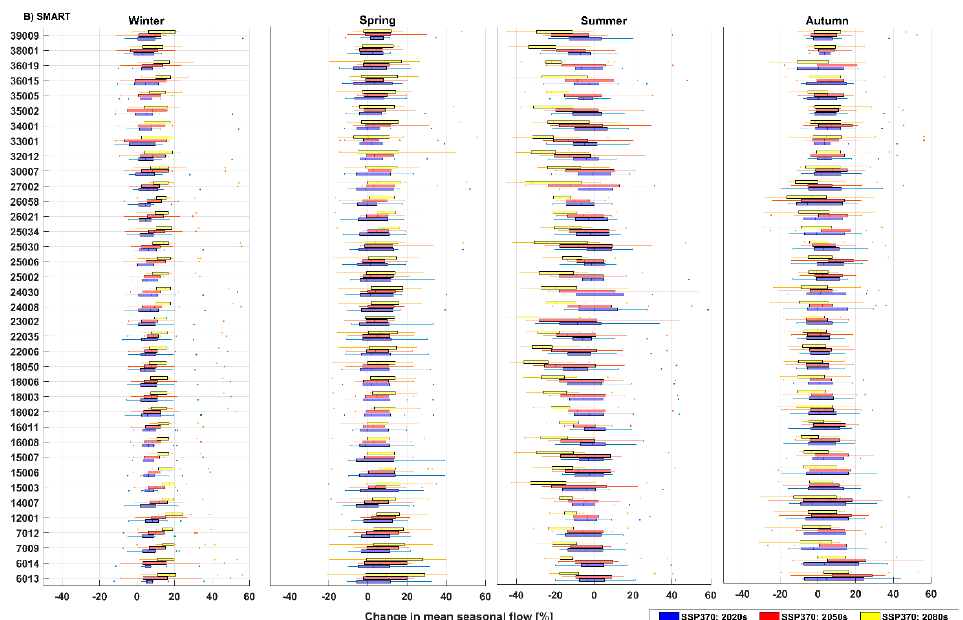
Figure 6. As in Figure 5, but for Figure 6 . As in Figure 5, but for SSP370.